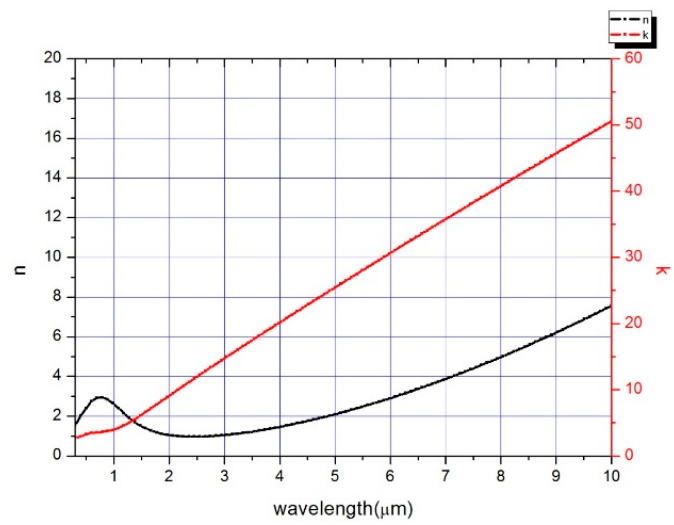
Figure 7. The optical constant of the Mo reflective layer.